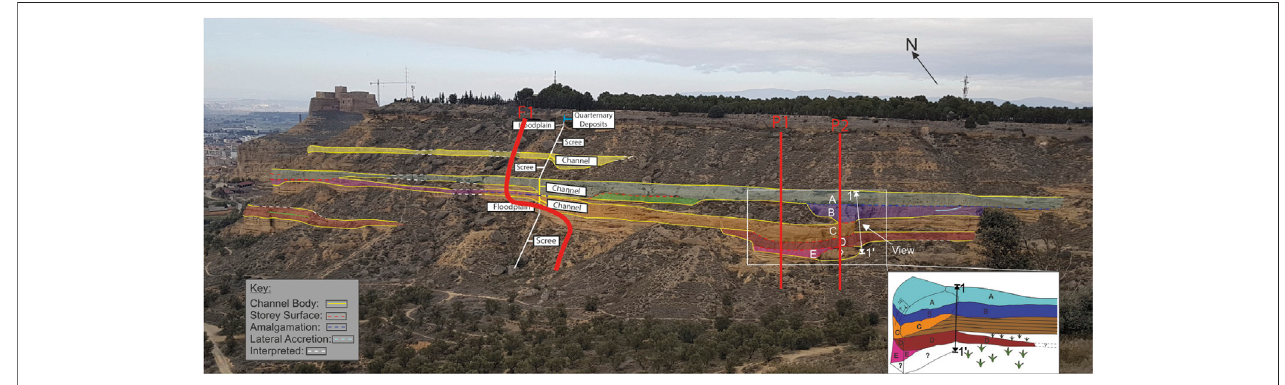
FIGURE 2 | Outcrop image of Monzón, indicating how the variation in channel amalgamation can result in a high variance in channel percentage statistics, see P1 andP2fortwopossiblepseudo-loglocations.Differencebetweenpseudo-logpathand fi eldpath(F1)isindicated.Notethe fi eldsectionrouteisdictatedbyaccessibility while the pseudo-log location is not. Letters A – E represent different storey packages.